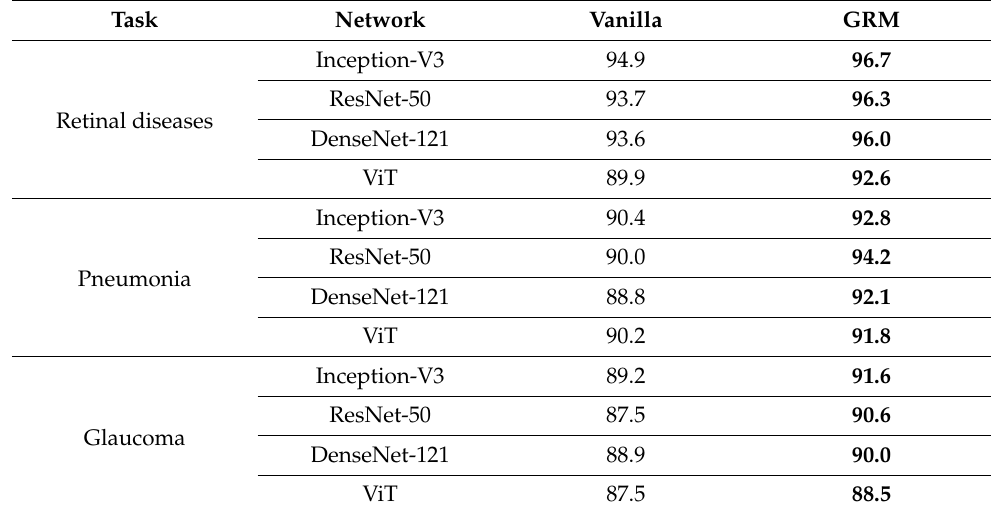
Table 2. Comparison of accuracy (%) between the vanilla networks and the one applied with GRM on the three medical image analysis